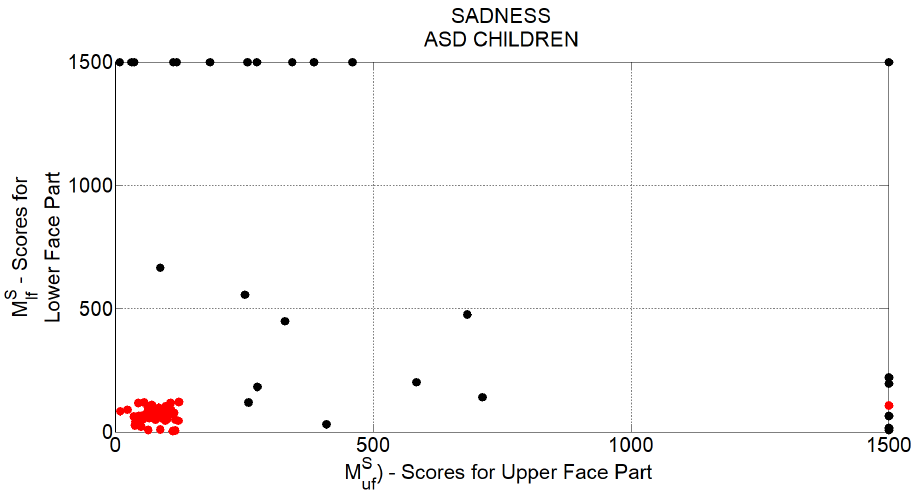
Figure 8. Scores computed for the production of Happy expressions by ASD children.